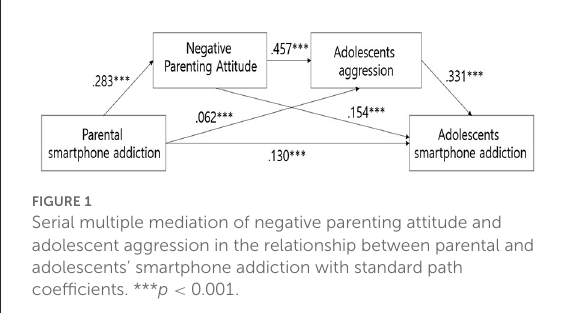
FIGURE1 Serial multiple mediation of negative parenting attitude and adolescent aggression in the relationship between parental and adolescents’ smartphone addiction with standard path coefficients. *** p < 0.001.